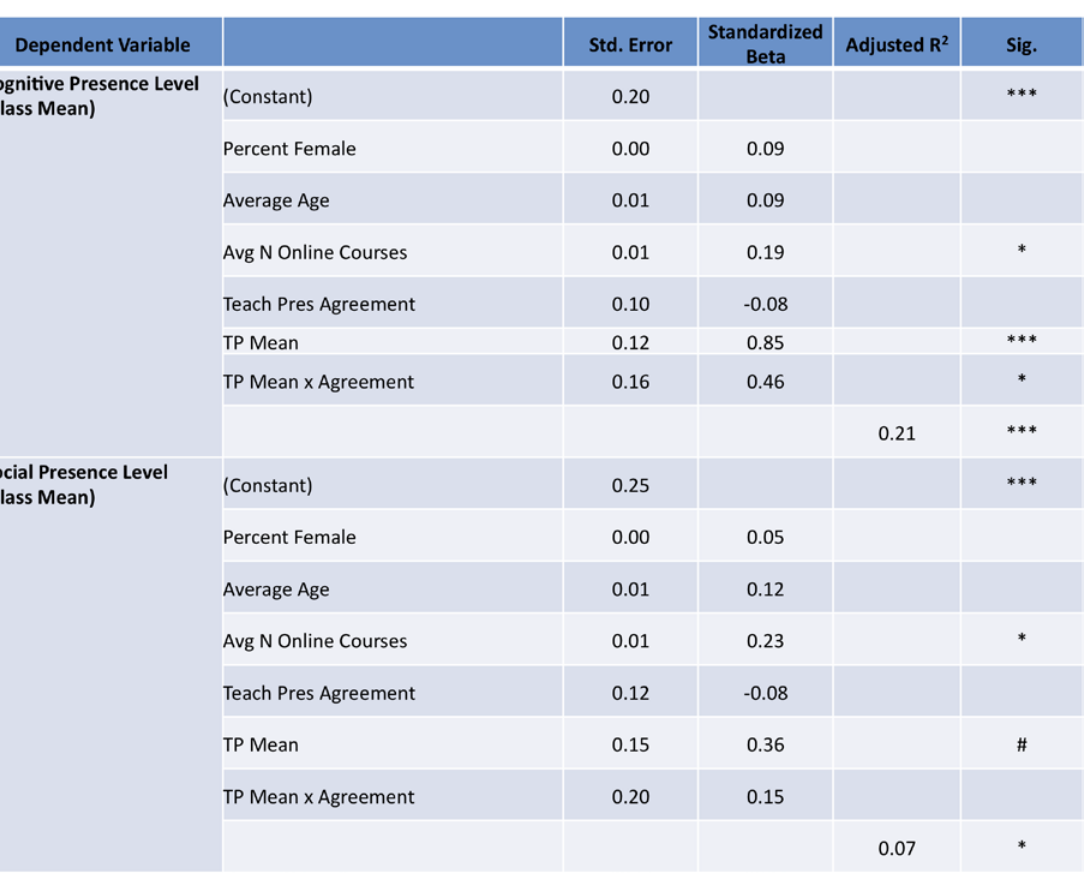
Effect of Class Levels and Agreement about Teaching Presence on Levels of Cognitive and Social